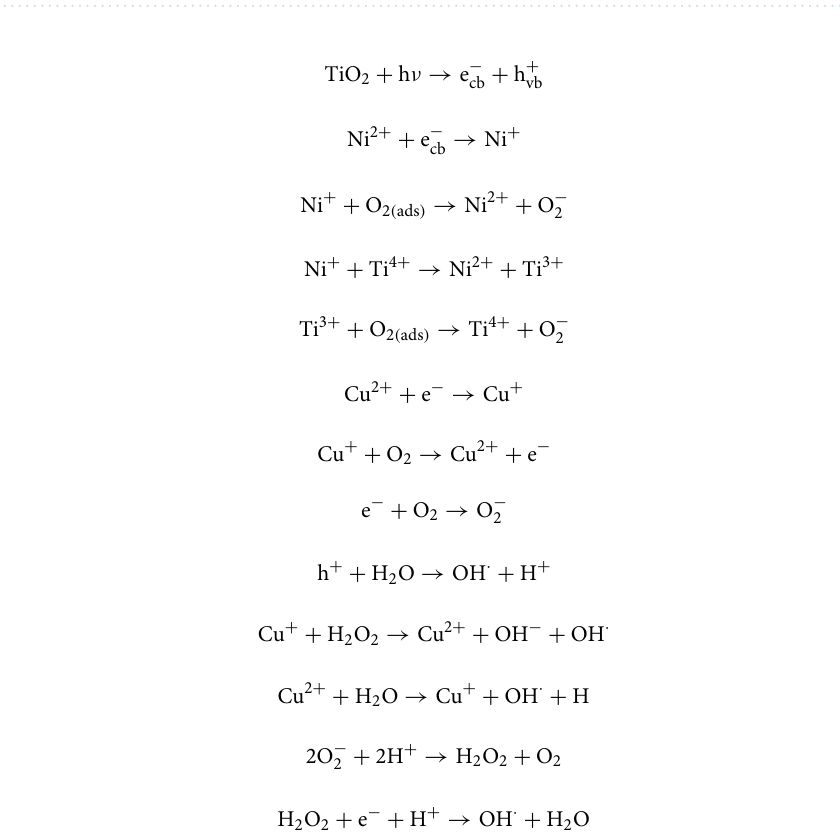
Figure 13. A possible electron transfer reaction mechanism during the photocatalytic degradation